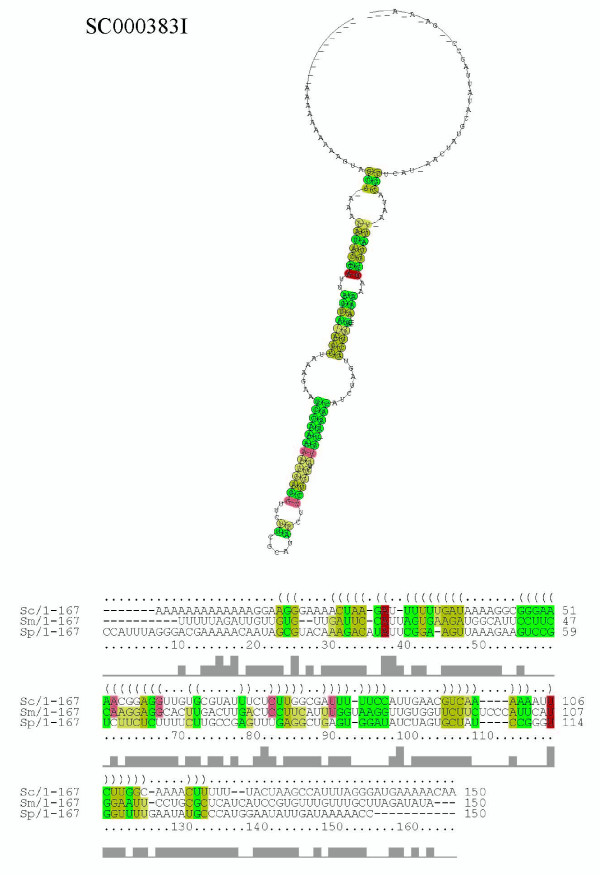
Consensus structure and alignment of ncRNA candidate SC000383I. This alignment is composed of a S. cerevisiae sequence (chr10/550,008–550,157 bp/-), a S. mikatae sequence (c2712/2,245–2,394 bp/-), and a S. paradoxus sequence (c303/5,880–6,029 bp/-). The averege pair sequence identity of this alignment is 28%.